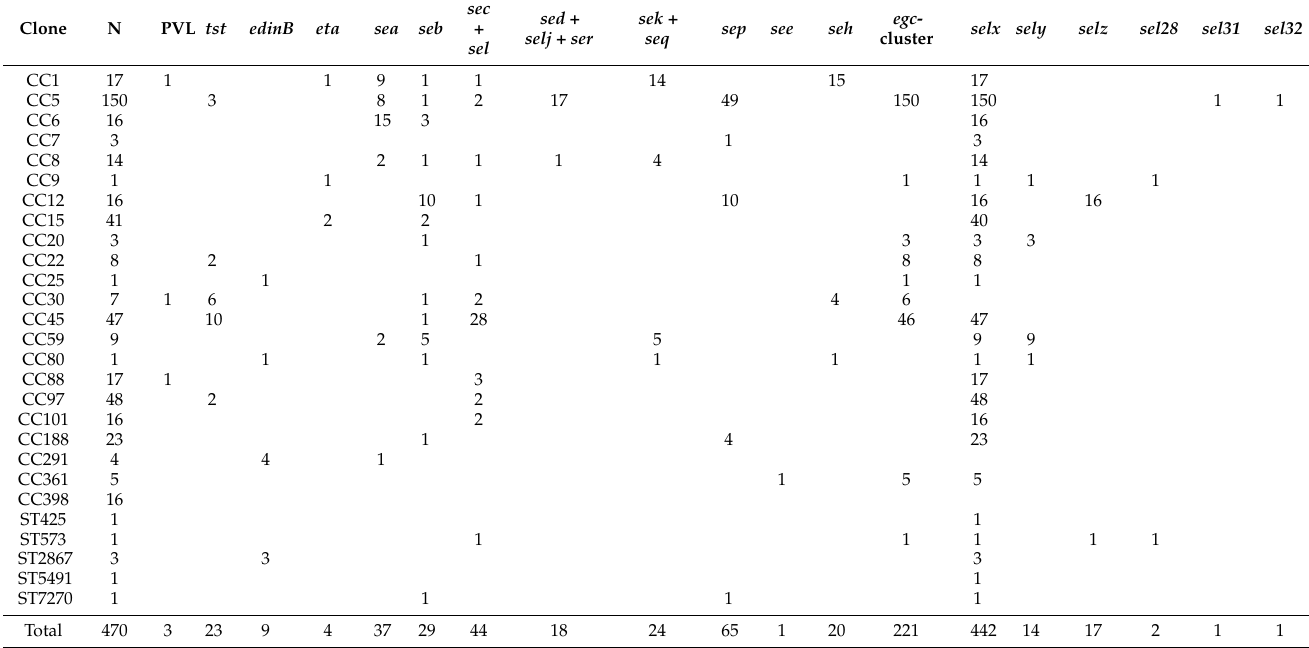
Table 1. The prevalence of virulence genes detected by whole genome sequencing in 470 penicillin- susceptible Staphylococcus aureus with different clonal